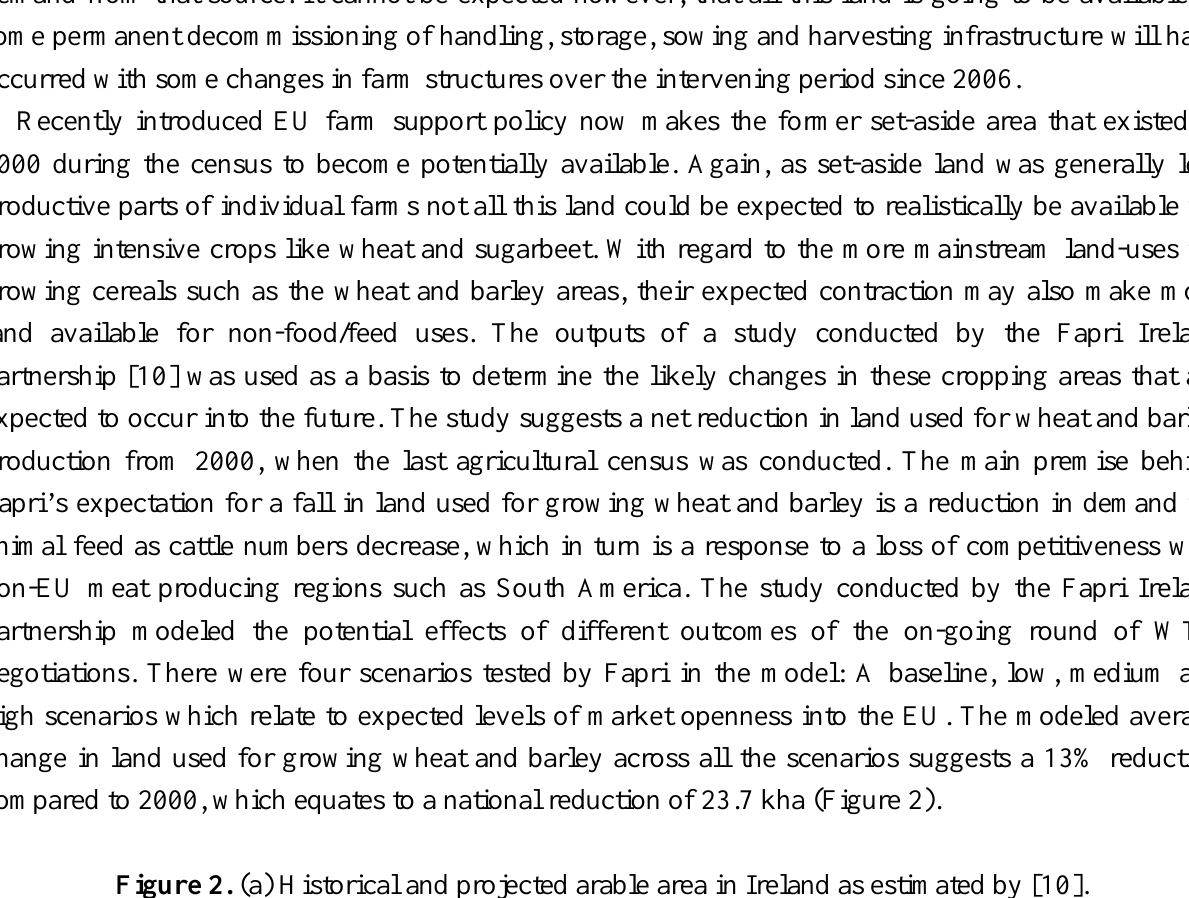
Figure 2. (a) Historical and projected arable area in Ireland as estimated by